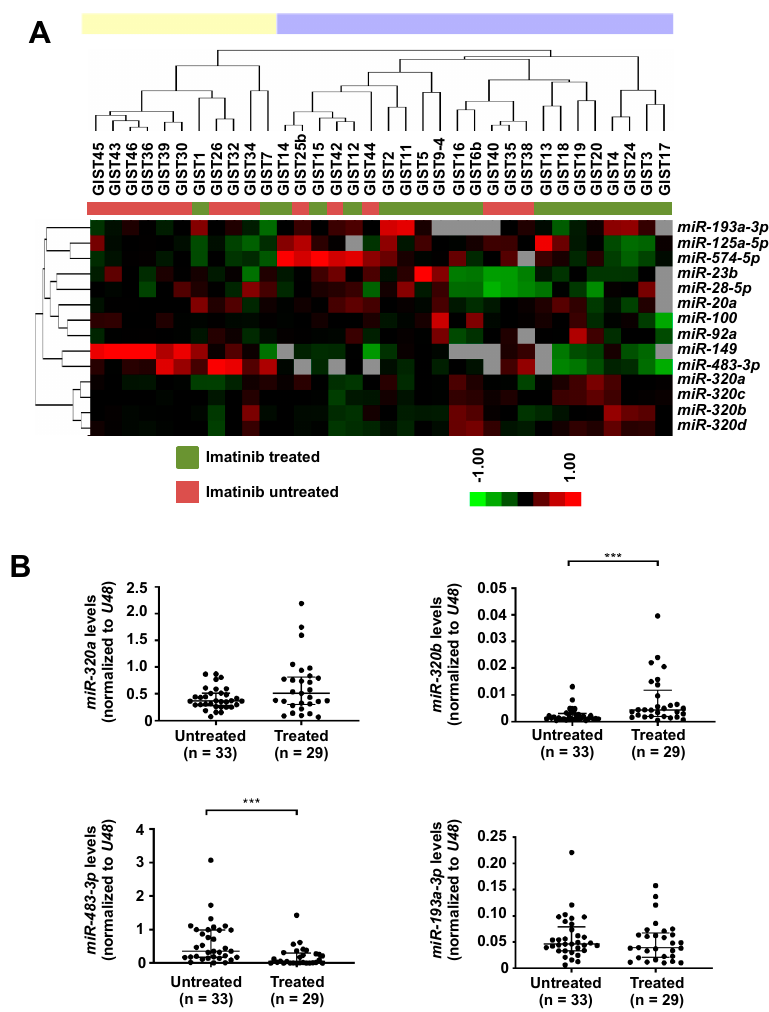
Figure 1. miRNA expressions in imatinib-treated and untreated gastrointestinal stromal tumor (GIST) samples. ( A ) Hierarchical clustering of the 14 differentially expressed miRNAs between imatinib-treated ( n = 19) and untreated GISTs ( n = 15) was performed based on the Spearman’s Rank Order Correlation and complete linkage. Red and green in the heatmap refer to higher and lower expressions, respectively. The two main clusters are indicated by yellow and blue bars above the dendrogram. ( B ) RT-qPCR analysis of four selected differentially expressed miRNAs in an extended cohort of 33 untreated and 29 treated GIST samples. *** p < 0.001 by Mann–Whitney U-test.